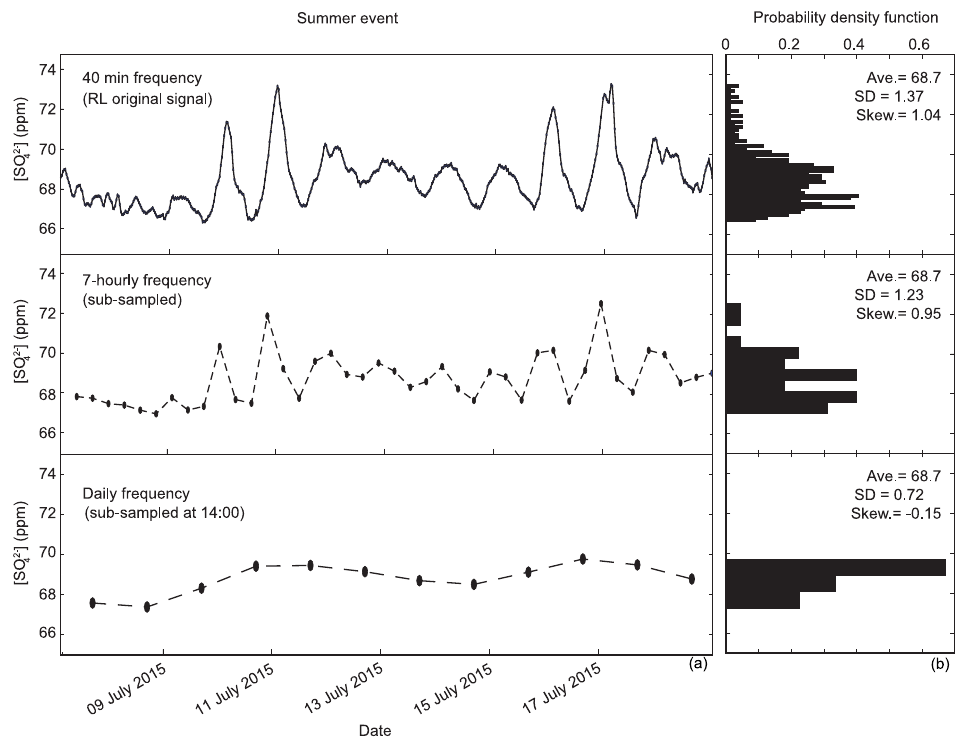
Figure 6. (a) Sulfate concentration in the Orgeval River during a summer event (from 7 to 19 July 2015) sampled every 40min (RL original signal) and artificially subsampled every 7h, and every day at 14:00. Probability density functions (PDFs) of concentration are represented as histograms (b) . For each PDF, the following statistical parameters are calculated: average (Ave.), standard deviation (SD), and skewness